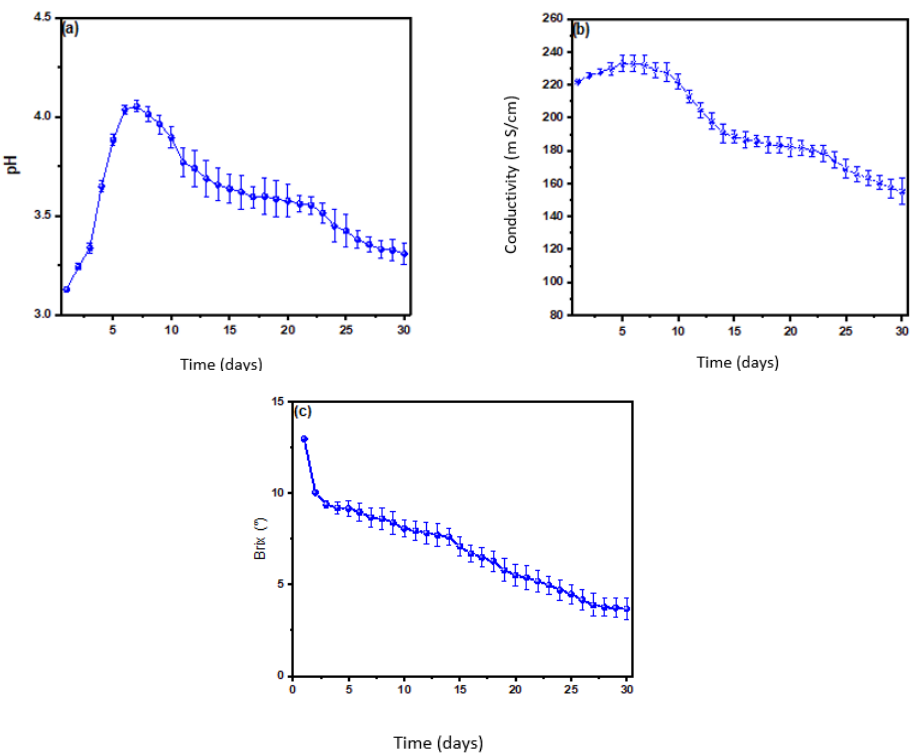
Figure 3. Monitoring of values of ( a ) pH ( b ) conductivity and ( c ) degrees Brix of MFC for 30 days.